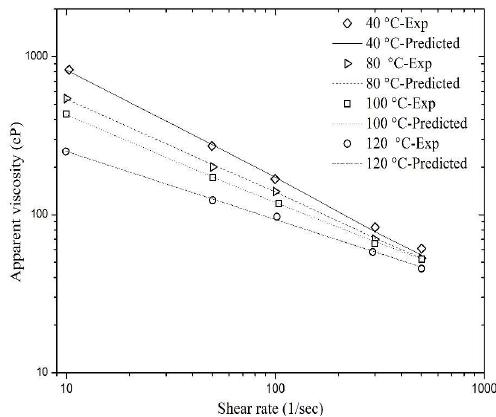
Figure 10. Match of the predicted viscosity values of sCO 2 foam using Equation (11) with the experimental data shown in Figure 2.